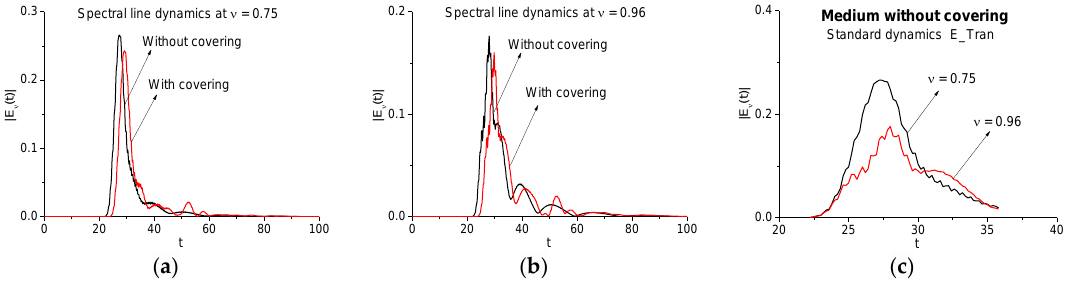
Figure 8. Spectral line dynamics at the frequencies ν = 0.75 ( a ), 0.96 ( b ) for the pulses transmitted through the medium without covering (E_Tran) and with it (Cov_Tran) in the full time interval t = [0, 100]. Spectral line dynamics of the standard pulse E_Tran calculated at the frequencies ν = 0.75, 0.96 using the time interval t = [20, 35] ( c ).